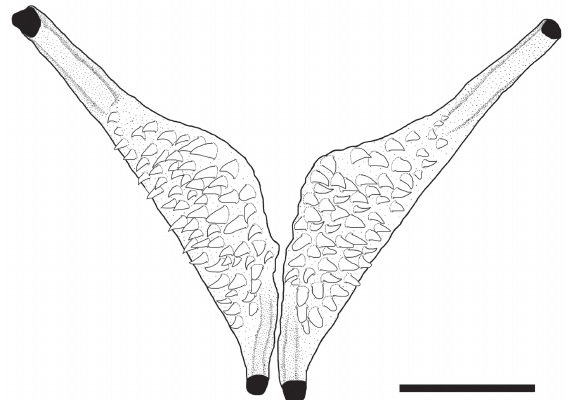
in occlusal view, MZUSP 55113, paratype. Scale bar = 1